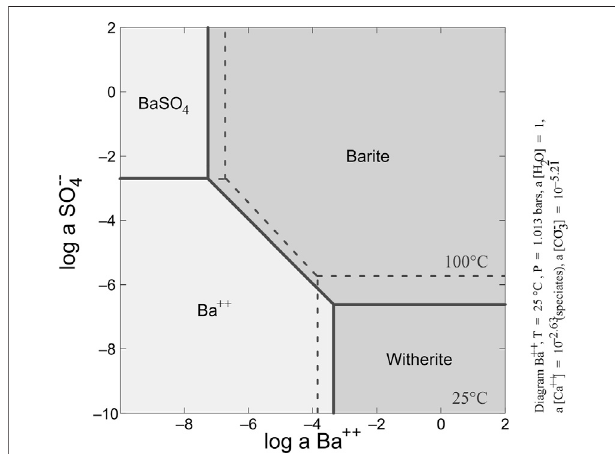
FIGURE 14 | Phase diagram showing barite and witherite stability fi elds typical of modern seawater at 25 o C and 100 ° C with a(Ca 2+ ) (cid:1) 10 − 2.63 and a(CO 32- ) (cid:1) 10 − 5.21 . Parameters for phase diagram from Maynard and Okita